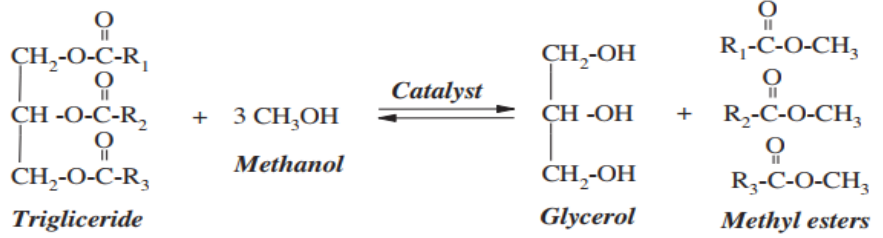
Figure 1. Transesterification reaction, where R 1 , R 2 , and R 3 are long hydrocarbon bonds. The reaction is reversible, hence the need for excess alcohol to shift the equilibrium toward the formation of ethyl/methyl esters